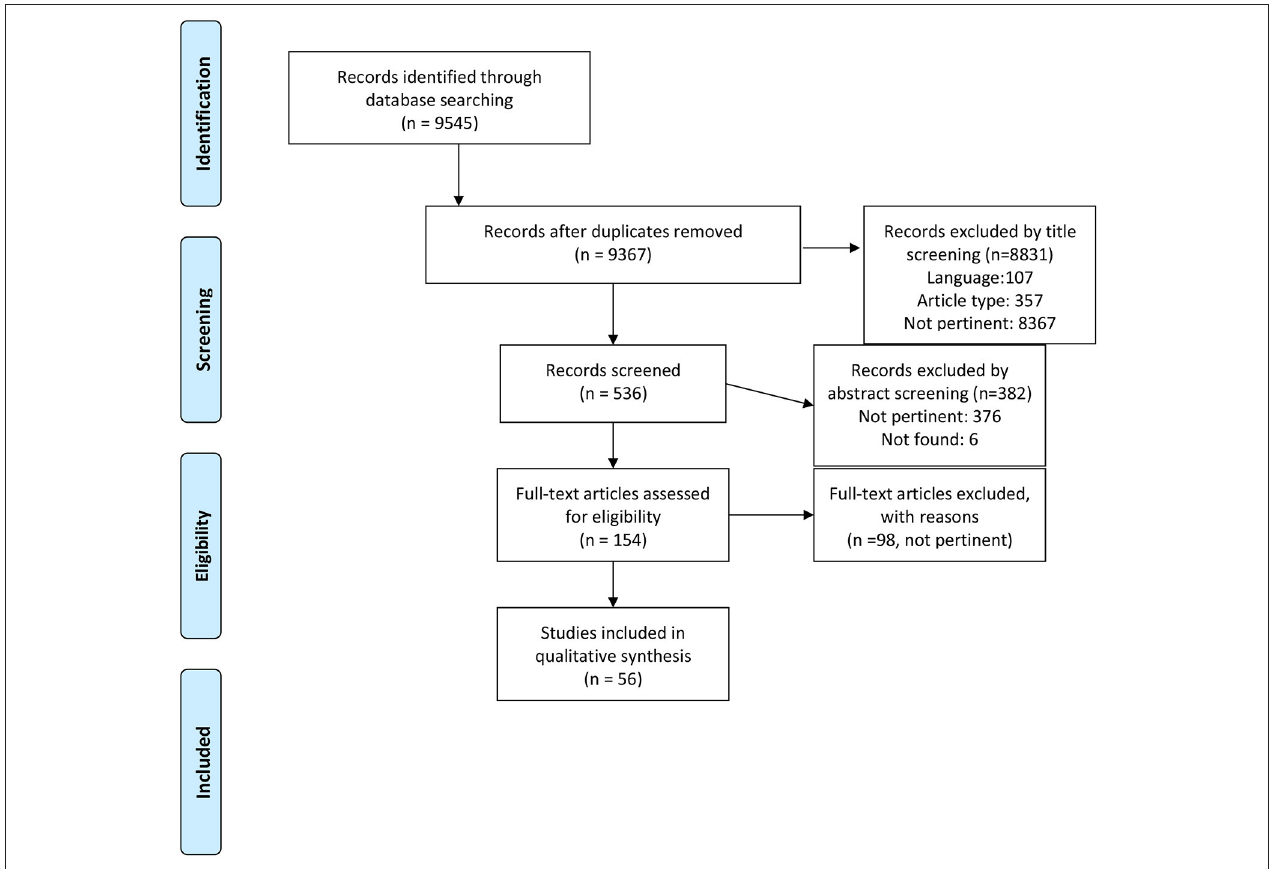
FIGURE 1 | PRISMA 2009 flow diagram. From: Moher et al.